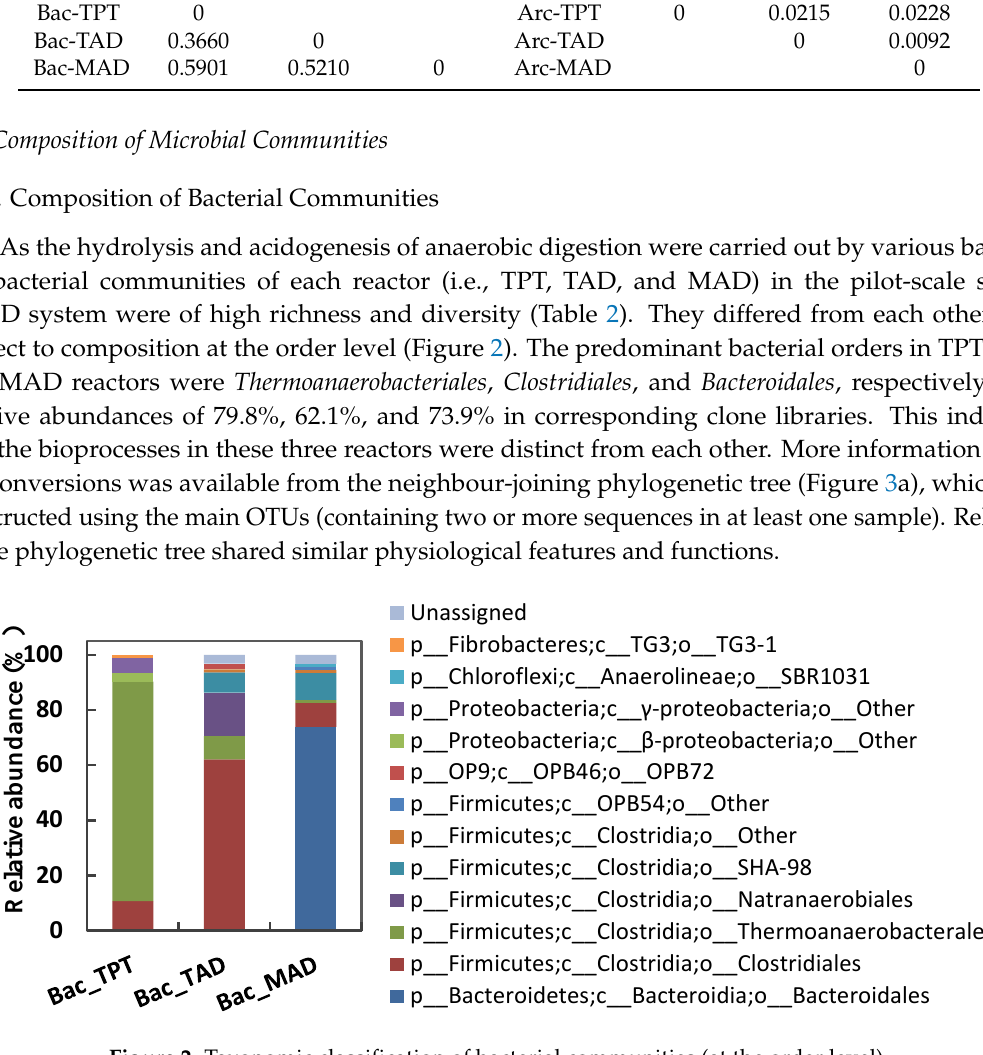
Figure 2. Taxonomic classification of bacterial communities (at the order level).